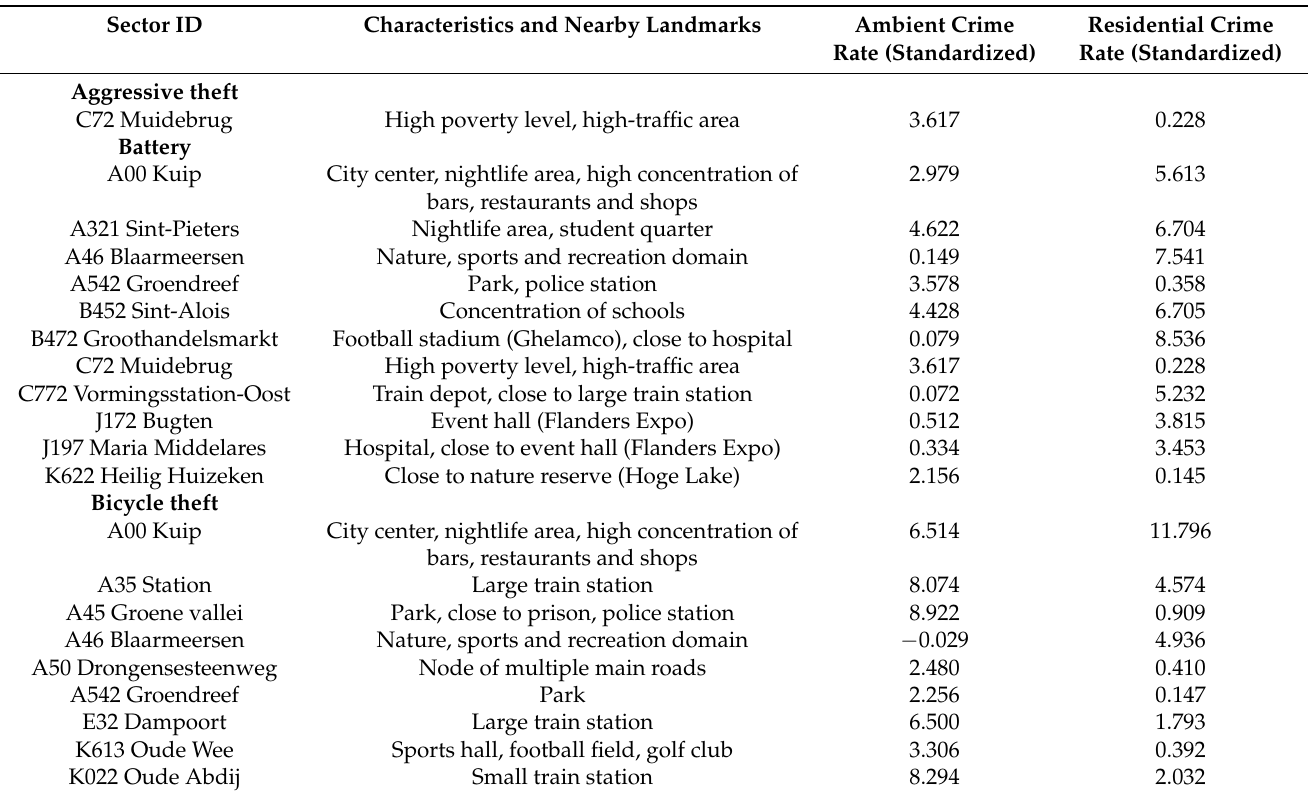
Table 4. Statistical sectors with different ambient and residential crime rates and their main characteristics. Sector ID Characteristics and Nearby